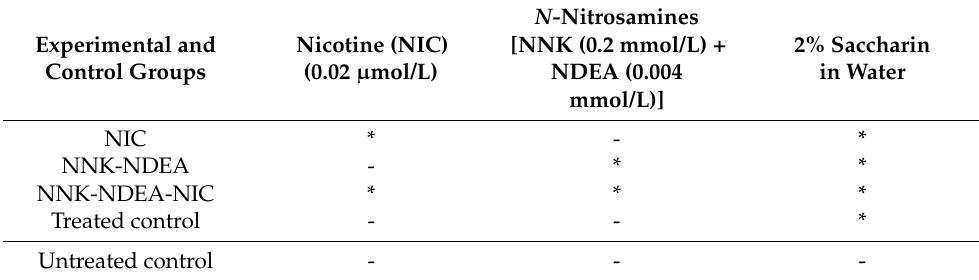
-/*, component of the experimental or control